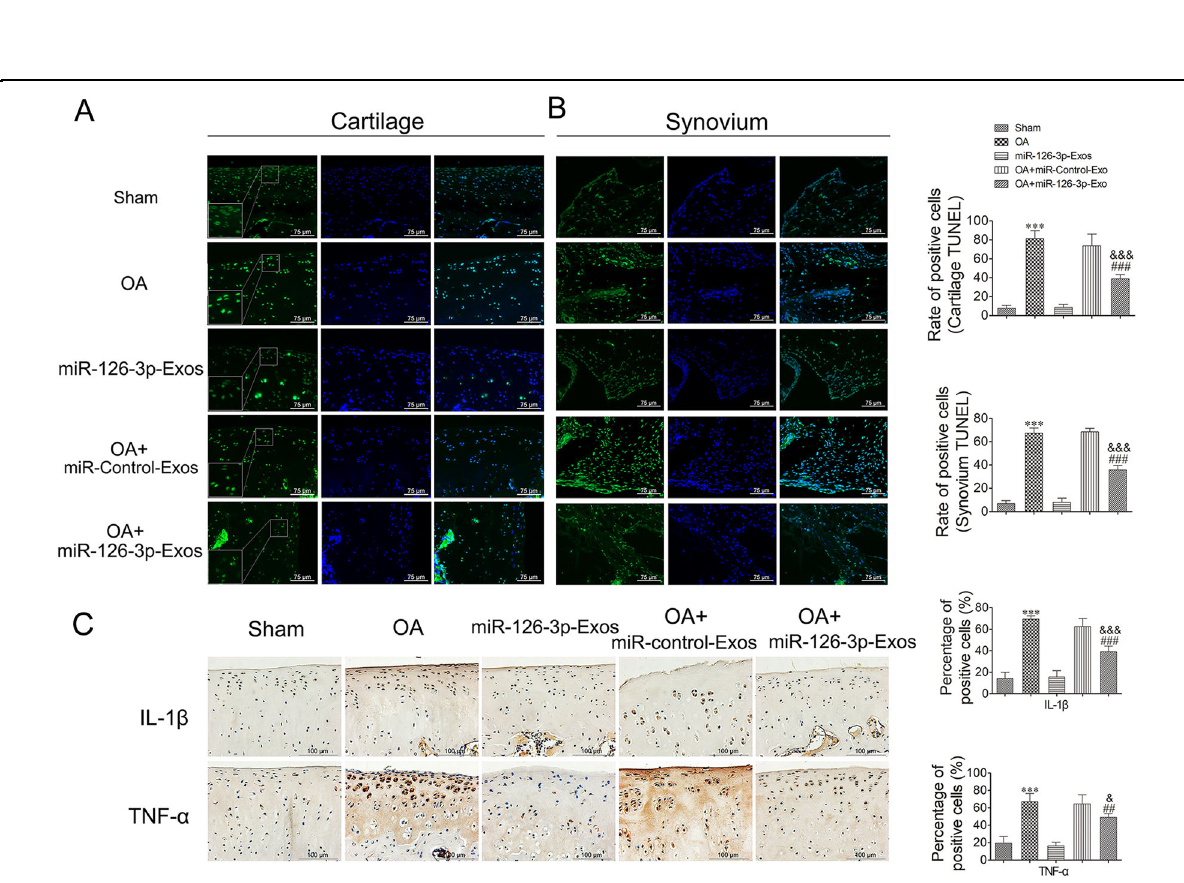
Fig. 6 Assessment of apoptosis and in fl ammation in cartilage mediated by SFC-miR-126-3p-Exos in OA model rats. A At 10 weeks post- surgery, animals were sacri fi ced and the knee joints were collected for TUNEL analysis. A representative TUNEL-stained section of articular cartilage was used to assess apoptosis. B Representative TUNEL-stained section of synovial tissues was used to assess apoptosis. C The immunohistochemical stainings of IL-1 β and TNF- α were performed in OA model rats. The ratios of immunoreactive positive cells were analyzed. Data were expressed as mean ± SEM ( n = 5). Data were expressed as mean ± SEM ( n = 5). *** P < 0.001 vs. sham-operated group; ## P < 0.01 and ### P < 0.001 vs. OA induction group; & P < 0.05, && P < 0.01, and &&& P < 0.001 vs. OA + miR-Control-Exos